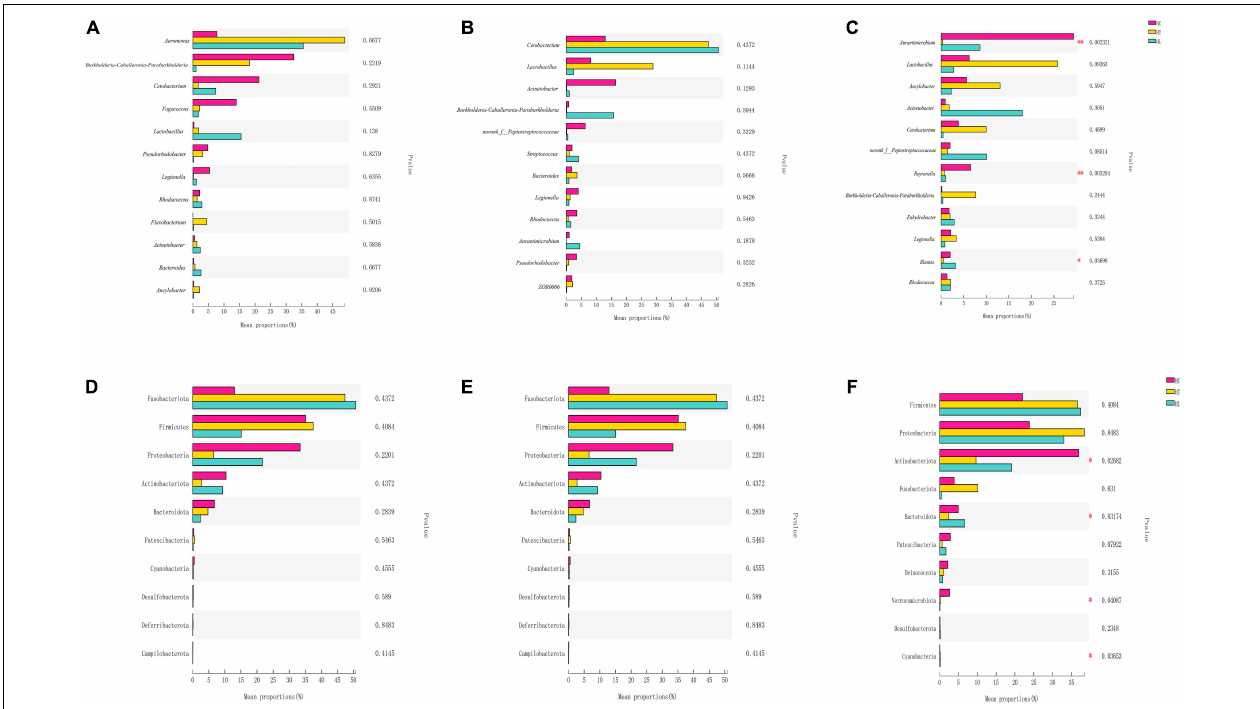
FIGURE 3 | Significant differences in relative abundance of the top 12 genera and top 10 phylum in different periods. (A) 5 days at the genera level, (B) 10 days at the genera level, (C) 15 days at the genera level, (D) 5 days at the phylum level, (E) 10 days at the phylum level, and (F) 15 days at the phylum level. ANOVA was chosen to find the differential abundance using a significance threshold of p < 0.05. “ ∗ ”indicates p < 0.05; “ ∗∗ ” indicates p < 0.01. HC: The control group, HT: The L. lactis 1,209 treatment group, HL: The L. lactis 1,242 treatment group.